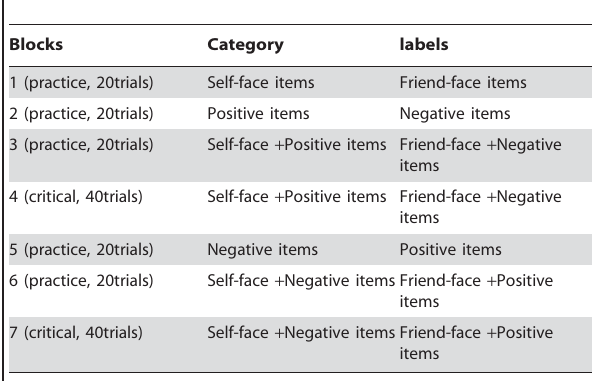
Table 1. A list of the categorization tasks in IAT in Experiment